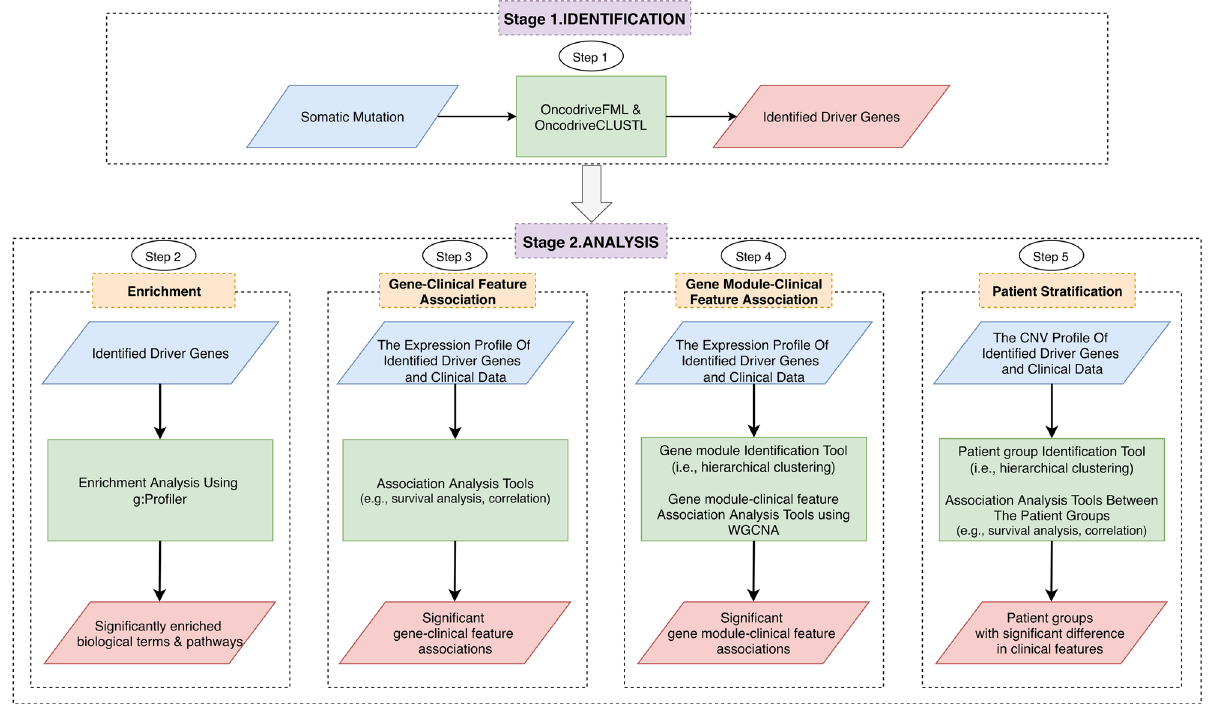
Figure 1. Improved analysis pipeline for identification and analysis of driver genes. The scheme comprises two stages: identification and analysis, in which the former uses the OncodriveFML and OncodriveCLUSTL